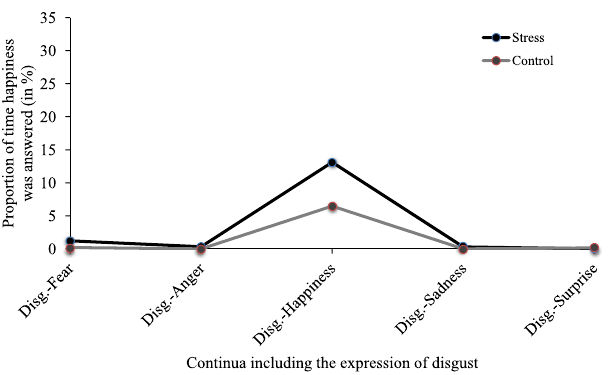
Figure 6. Proportion of time happiness was answered when disgust was the dominant expression presented; for each combination of emotions including disgust and between experimental